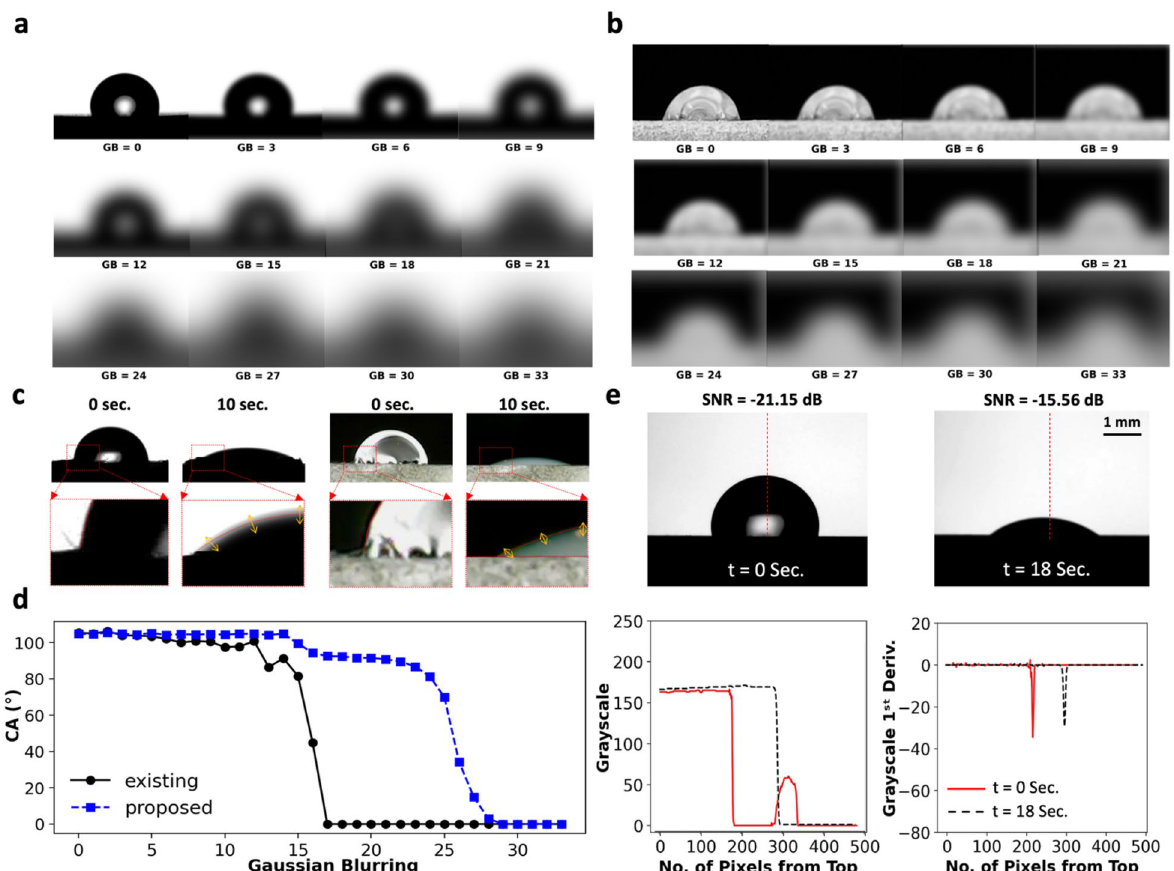
Figure 5. Impact of camera focus on the robustness of CA measurements: pinpointing the performance of the existing (fitting) and proposed (CNN) algorithms for surface wettability measurements of ( a ) back-lit and ( b ) front-lit images captured by the existing goniometer, and synthetically convoluted at different GB values. ( c ) Recognizing the boundary of front- and back-lit drops placed on a porous hydrophilic surface at 0 and 10 s from solid–liquid interaction using the fitting method. The ternary phase contact line is magnified, and the fitted (red) line is sketched by the algorithm along the edge of the drop. ( d ) Estimating the CAs as a function of the GB values. If the GB values exceed 12, the existing method becomes unstable and could not be used for reliable CA measurements. However, the proposed CNN model remains stable for precise analysis of more distorted images, i.e., GBs ≤ 22. ( e ) Calculating the SNR based on the variations in the grayscale values of the pixels located on the red dashed lines, proving that the drop image becomes unfocused with